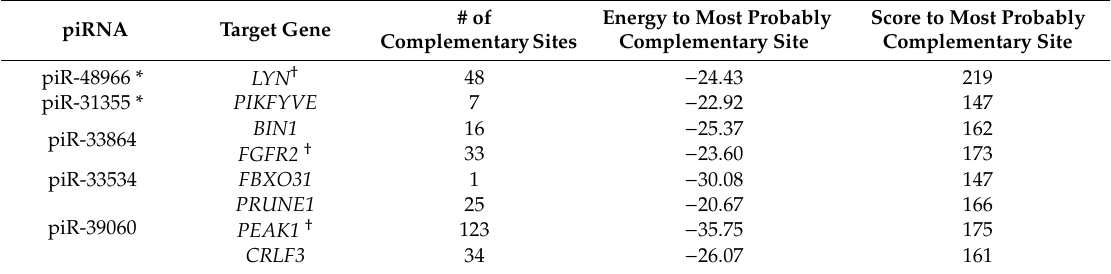
Table 2. ComplementaritybetweentheDEpiRNAsandsomecancer-relatedgenesatthetranscriptionallevel. # of Energy to Most Probably Score to Most Probably piRNA Target Gene ComplementarySites Complementary Site Complementary Site piR-48966 * LYN † 48 − 24.43 219